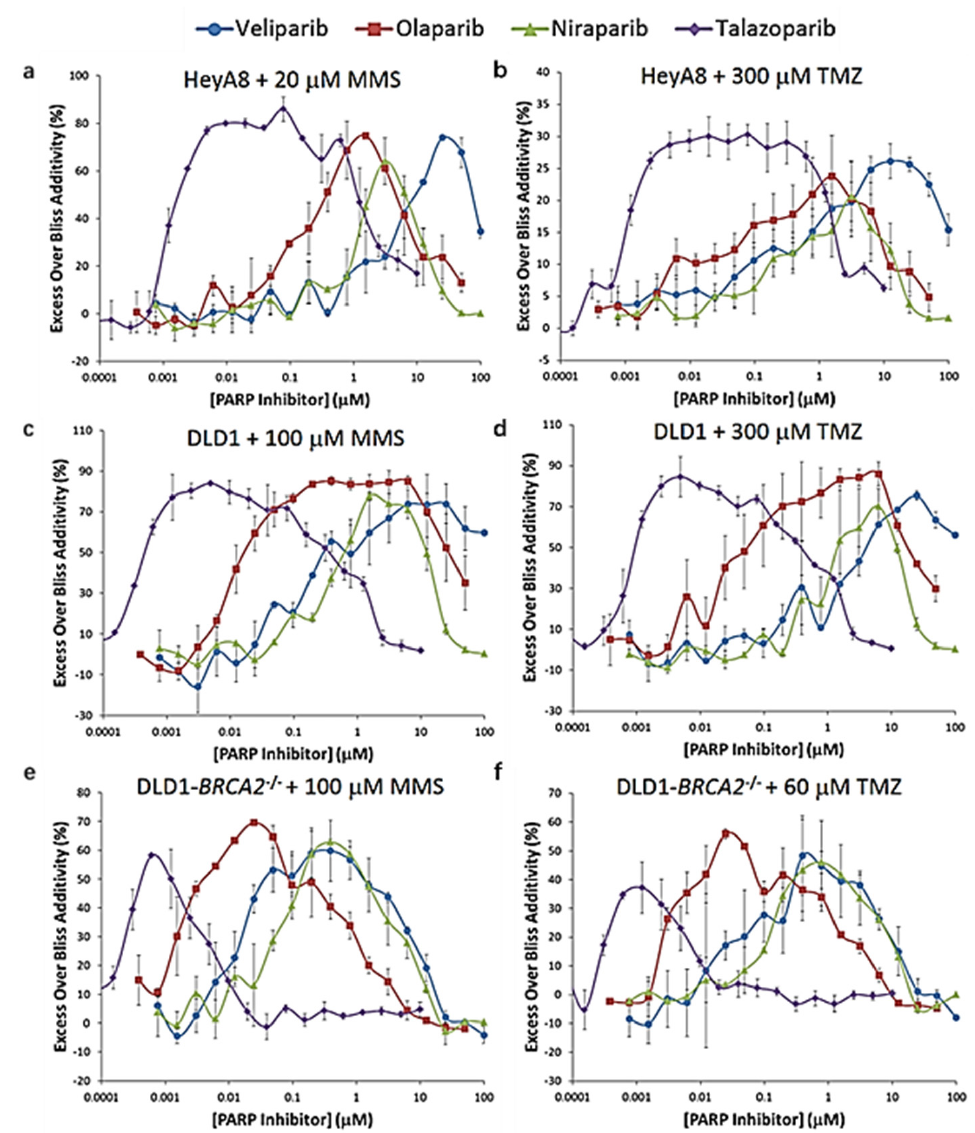
Figure 7. The synergistic effect of PARP inhibitor and DNA alkylating agent methyl methanesul- fonate (MMS) or TMZ in vitro. Cells were treated with two-dimensional dose responses of PARP inhib-itors and DNA alkylating agents for 5 days. Excess over Bliss additivity was determined for each condition. To facilitate comparison of PARP inhibitors, cross-sections of response surfaces at the concentrations of alkylating agent eliciting peak synergism are overlaid. In this analysis, values of zero indicate no activity or additivity whereas higher values indicate stronger synergism. The decreases observed at higher PARP inhibitor concentrations are due to a loss of synergism to single-agent PARP inhibitor activity. ( a ) HeyA8 cells with 20 µ mol/L MMS. ( b ) HeyA8 cells with 300 µ mol/L TMZ. ( c ) DLD1 cells with 100 µ mol/L MMS. ( d ) DLD1 cells with 300 µ mol/L TMZ. ( e ) DLD1- BRCA2 -/- cells with 20 µ mol/L MMS. ( f ) DLD1- BRCA2 -/- cells with 60 µ mol/L TMZ. Data represent means with standard errors from at least two independent experiments run in dupli-cate. Adapted from